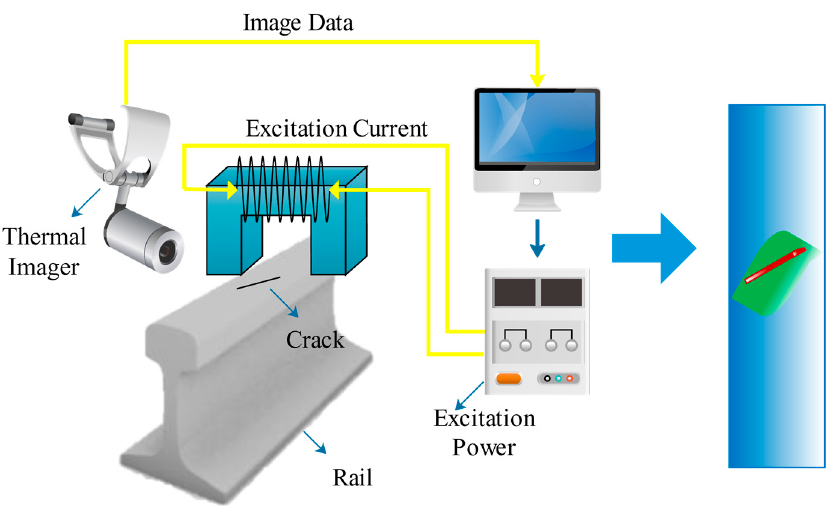
Figure 4. ECPT inspection for